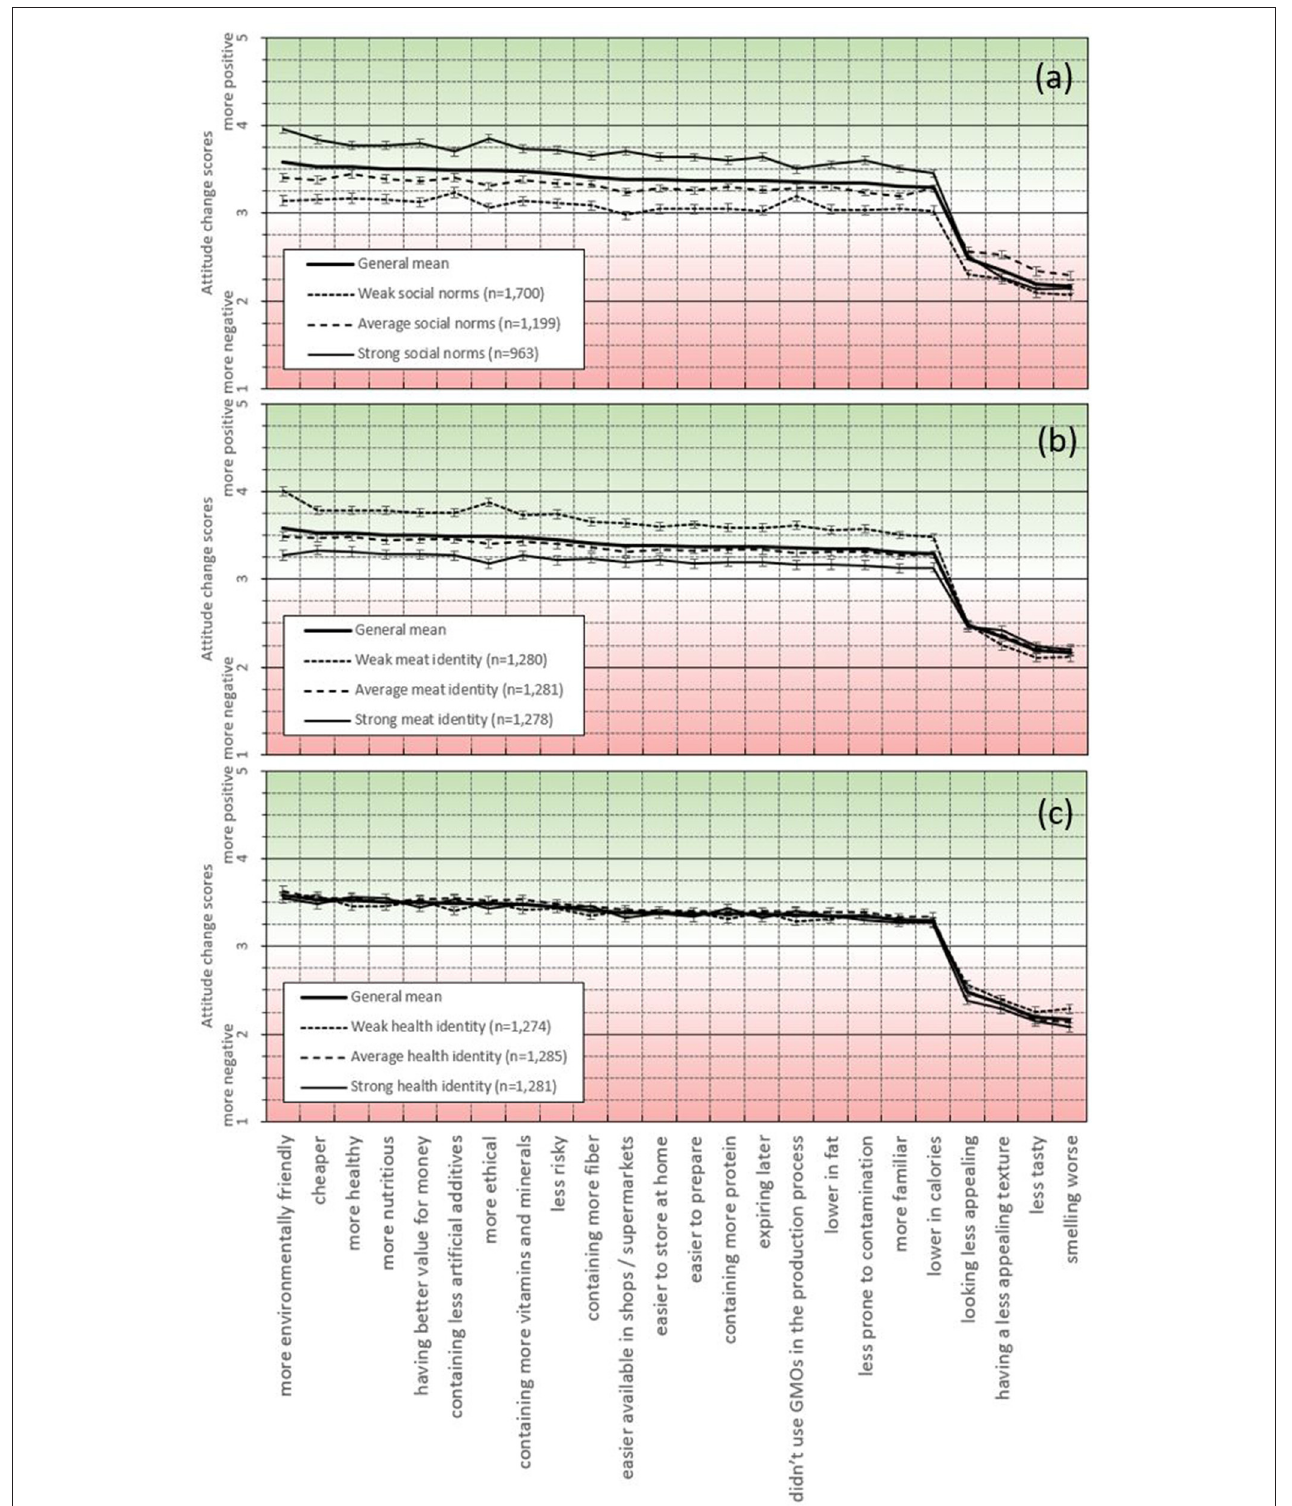
FIGURE 7 | Differences between social norm levels (a) , meat identity (b) , and health identity (c) . The error bars represent 95% credibility intervals estimated with Bayesian estimation.